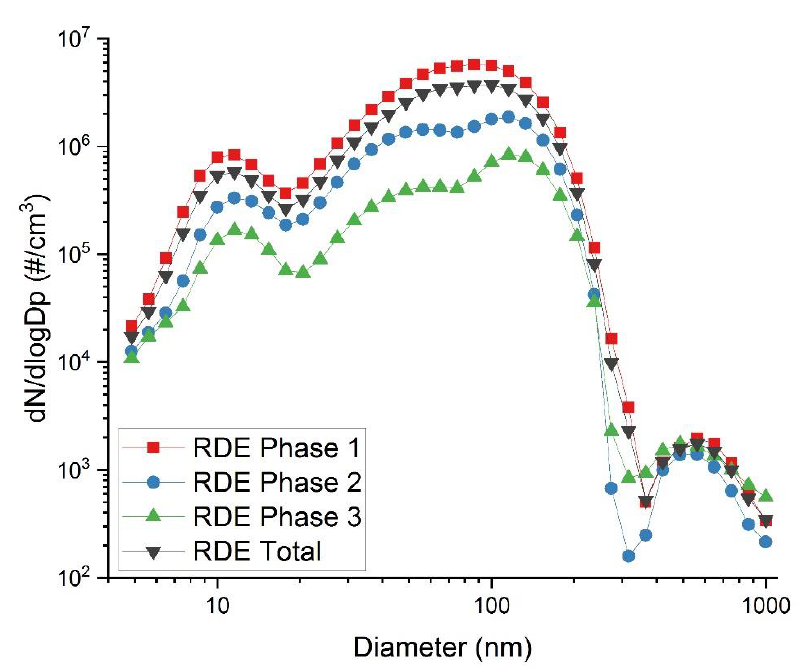
Figure 10. RDE total and phased average PNSD.